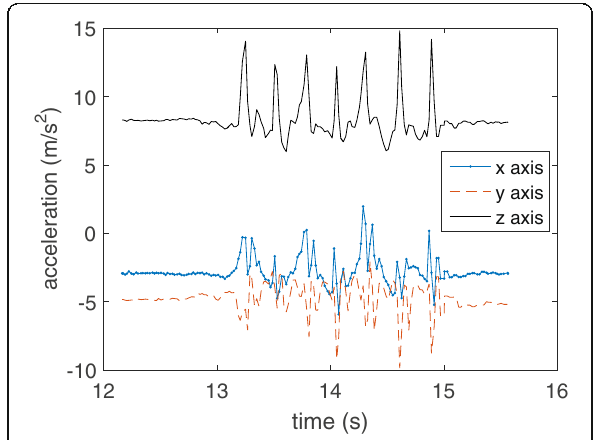
Fig. 1 The accelerometer data when a user types “ 924673 ” followed by “ Enter